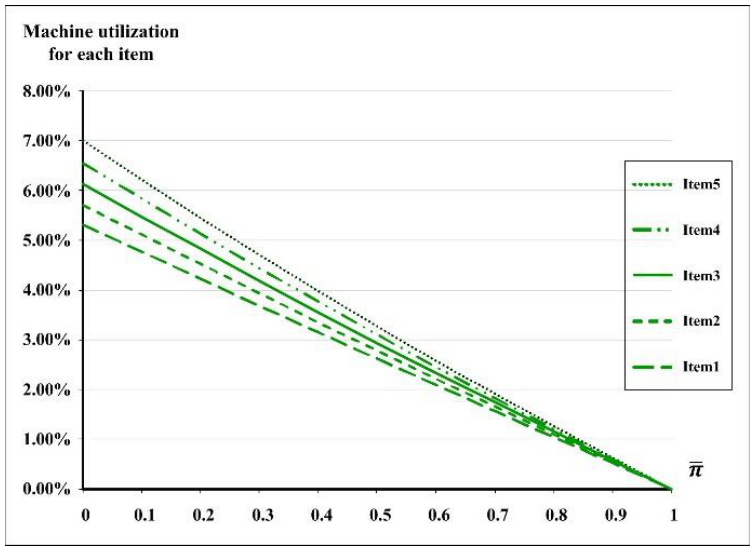
Figure 5. Impact of variations in  on machine utilization for each